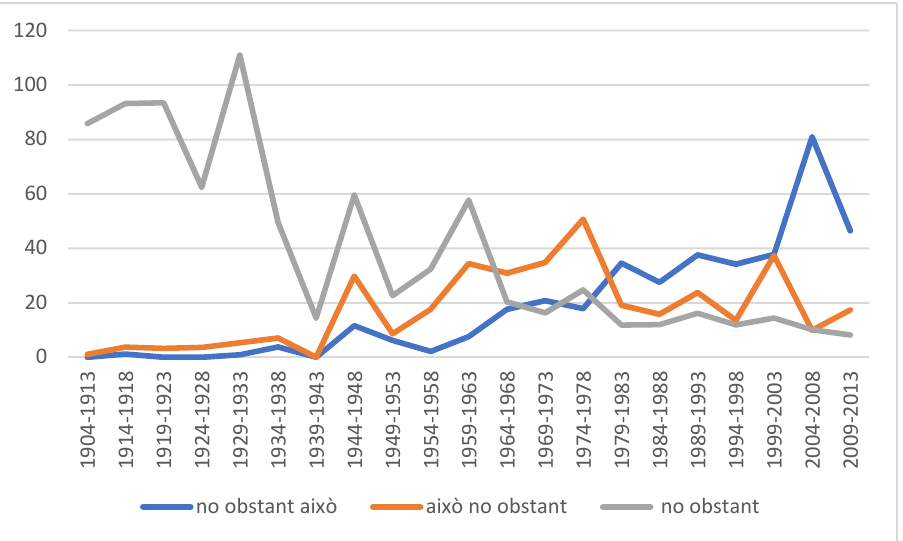
Figure 5. Relative frequency of the variants no obstant aix ò , aix ò no obstant, and no obstant (normalized per 1 million